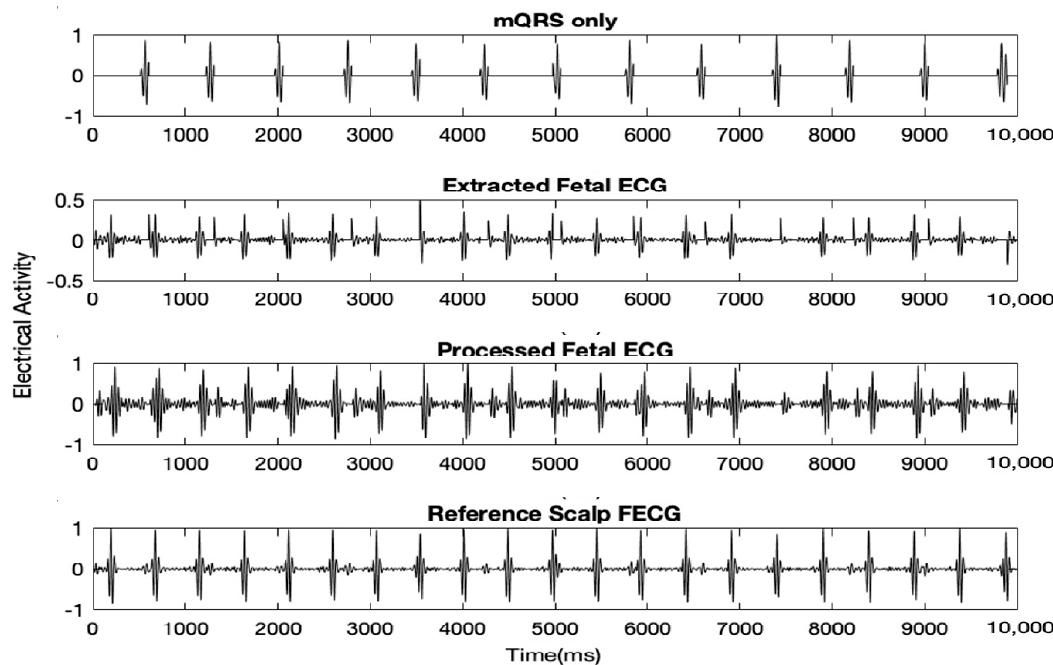
Figure 3. 10 s of clean MECG, extracted FECG and preprocessed FECG.